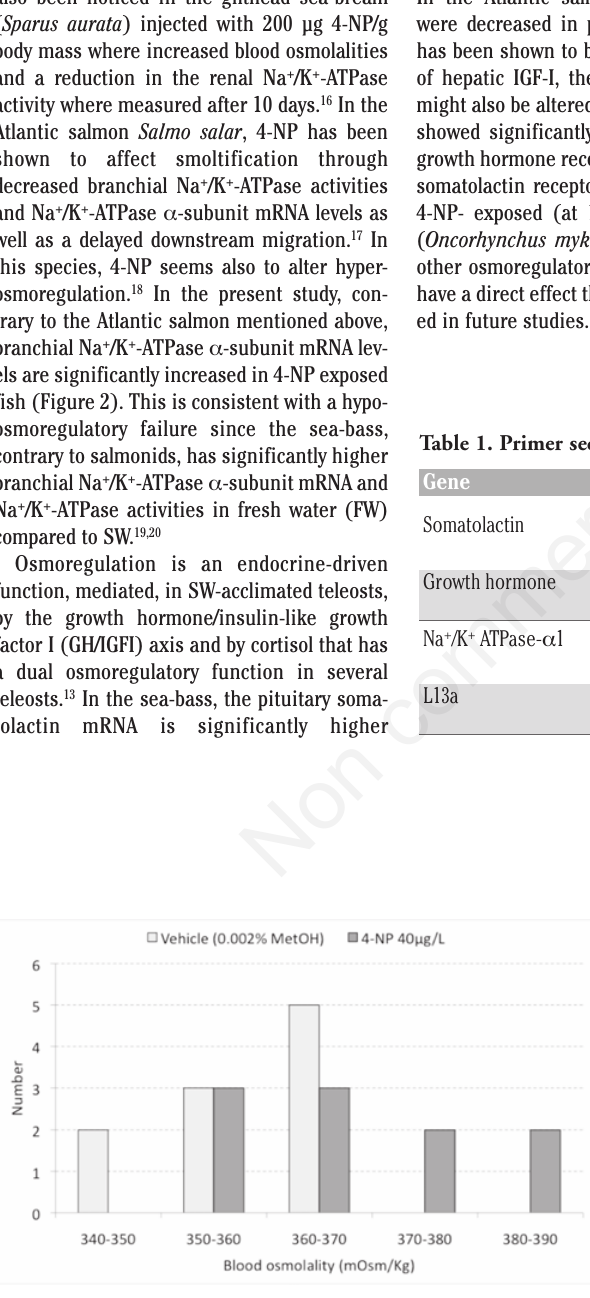
Figure 1. Blood osmolalities in D. labrax exposed to 40±20 μ g/L of 4-NP or vehicle only (0.002% MetOH).